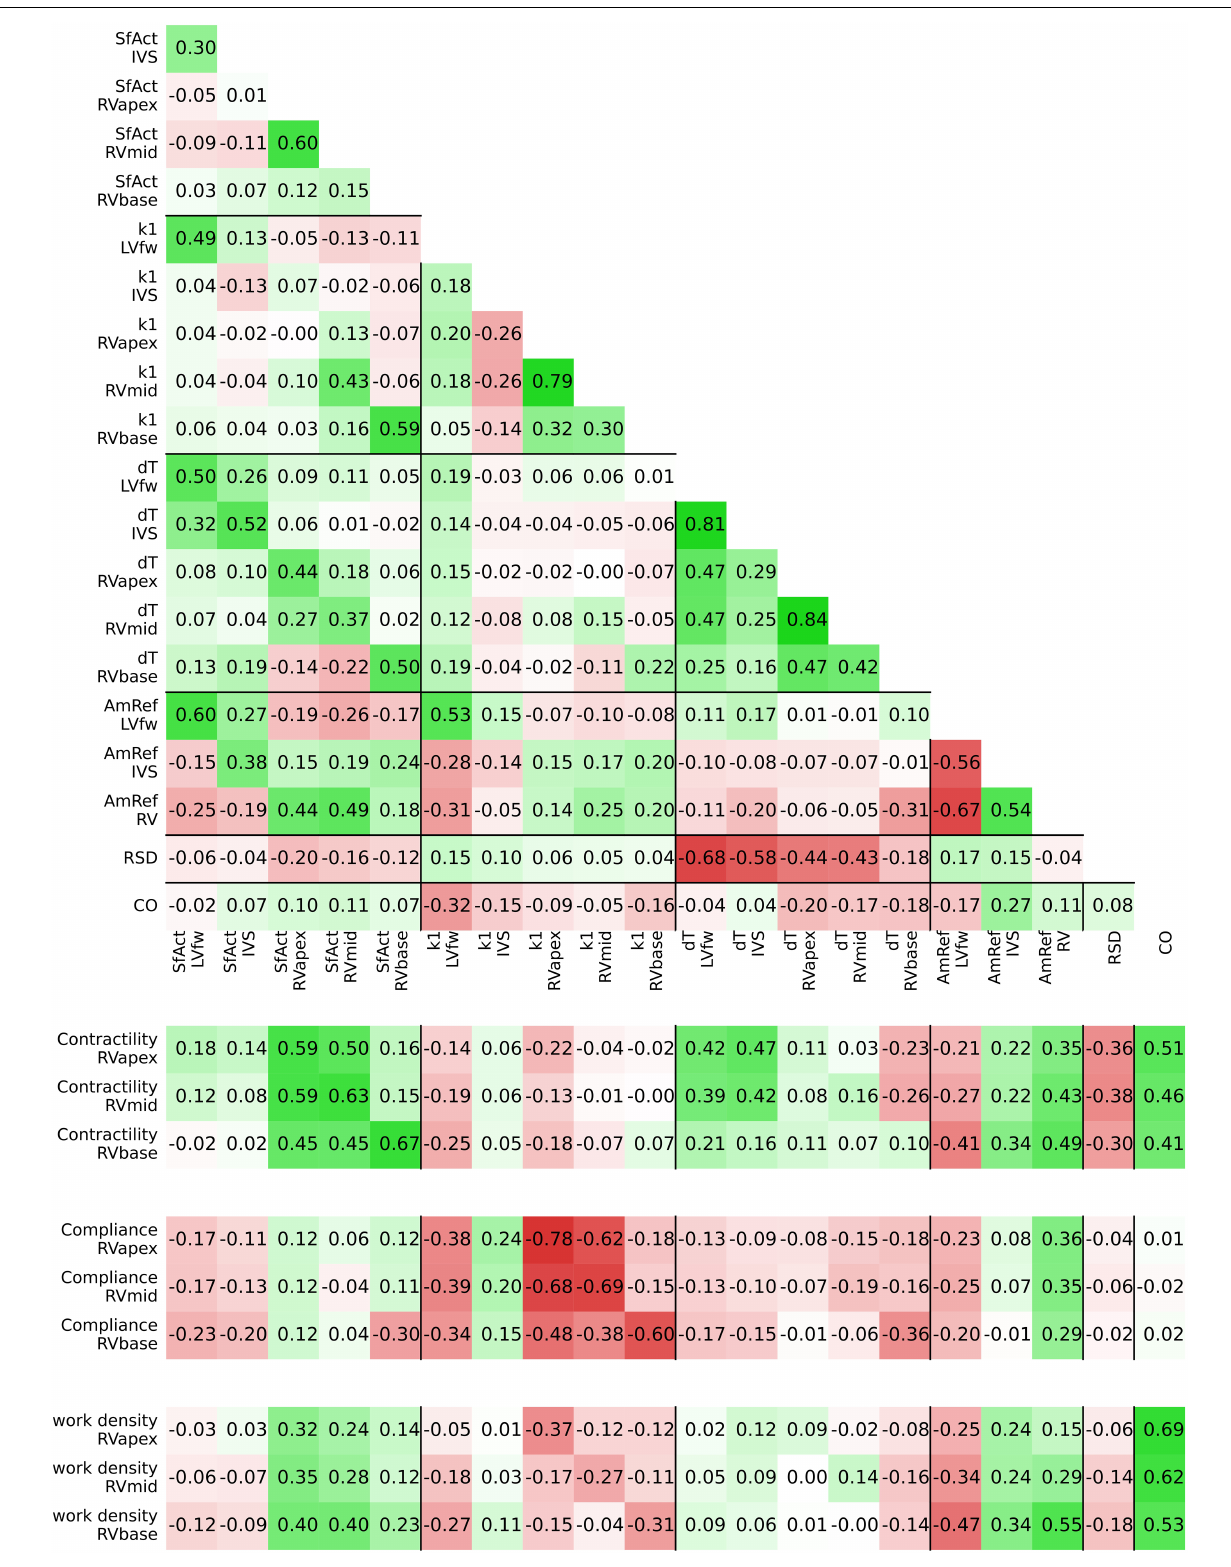
FIGURE 5 | Posterior correlation matrix of the estimated model parameters (top) and the correlation between the posterior distribution of model parameters and derived tissue properties (bottom).